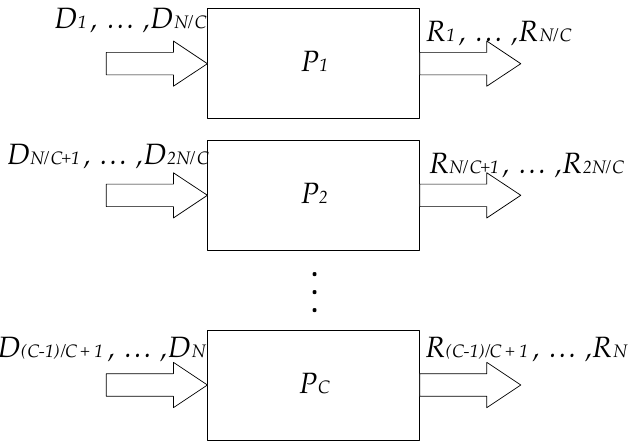
Figure 3. Scheme representing a parallel computing process.